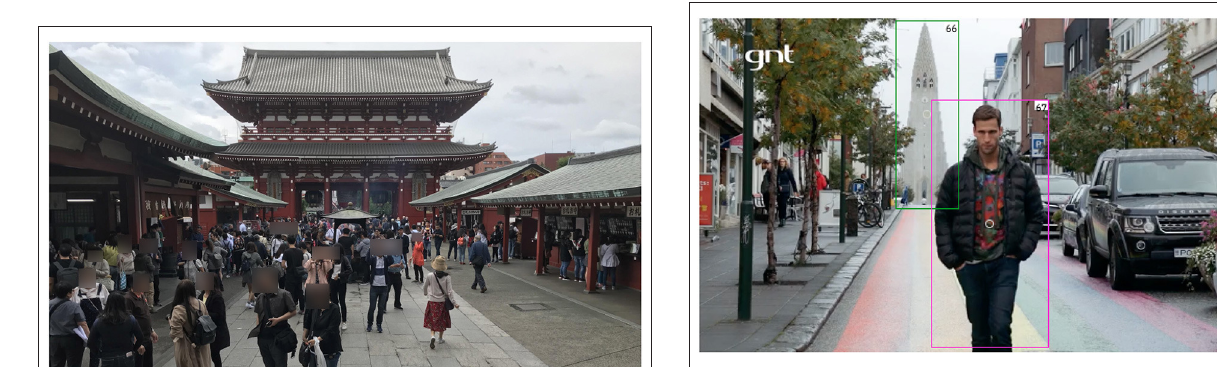
FIGURE 6 | A picture that evokes the Touring frame. Image source: Authors.